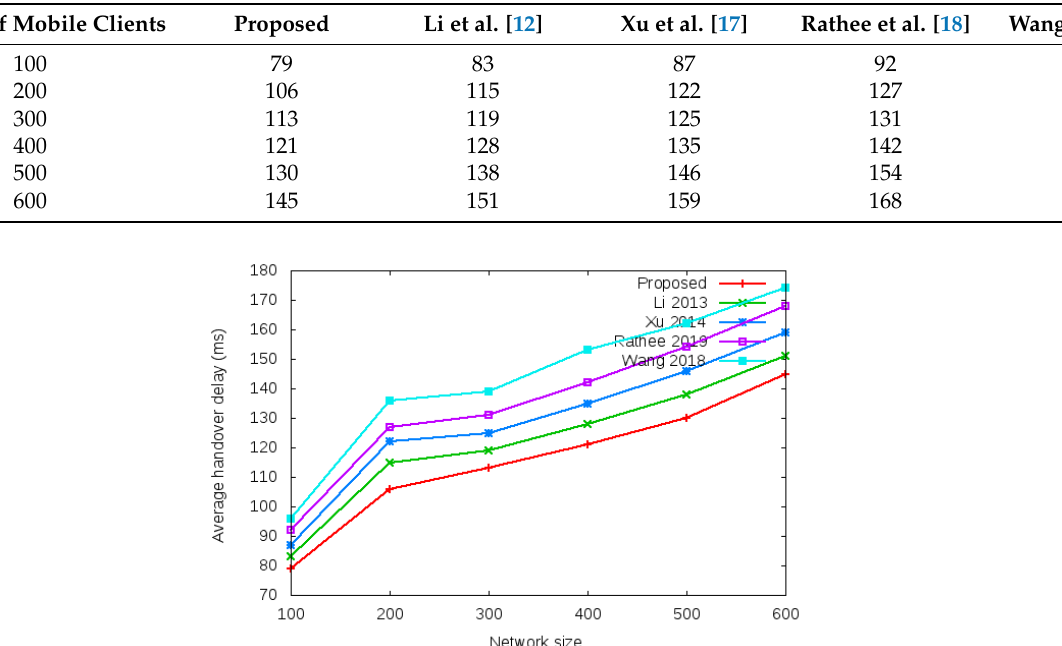
Table 9. Comparison on average handover authentication delay.